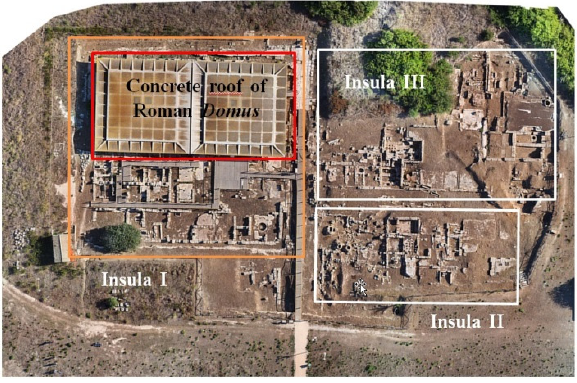
Figure1. Area of Insulae I, II, III and the Roman Domus.